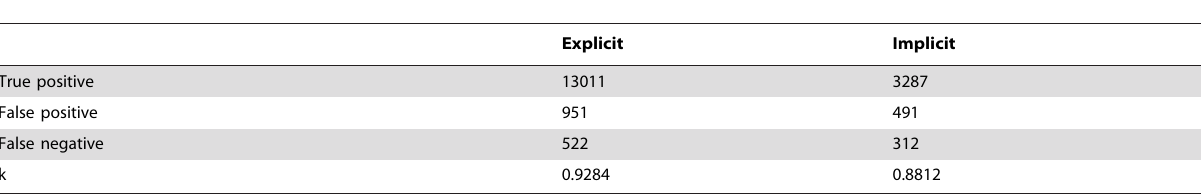
Table 1. Inter-annotator agreement between A1 and A2.